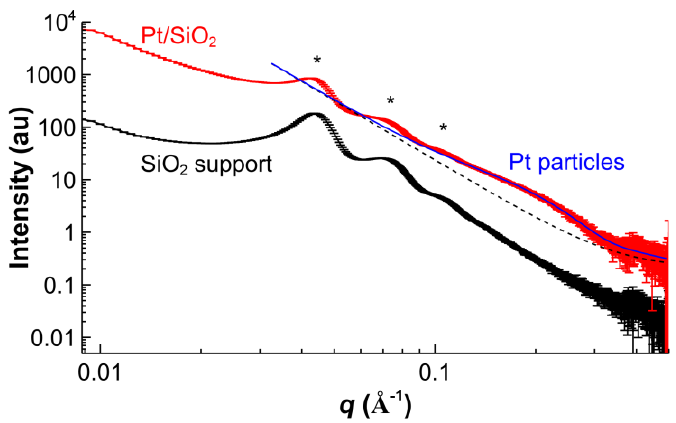
Figure 5. Small angle X-ray scattering obtained from the 12 wt % Pt/SiO 2 catalysts and the SiO 2 support. The overall fit for the Pt/SiO 2 is shown by the blue line and the fit without scattering from the Pt particles is given by the dashed line. The main features of SiO 2 is marked by *.